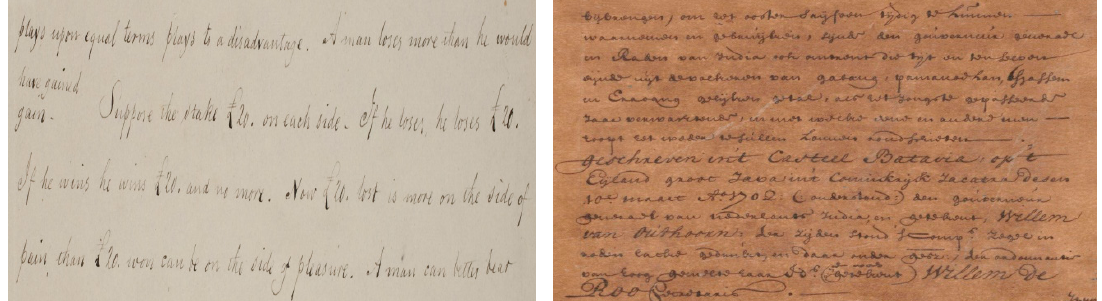
Figure 9. Example showing thin or weak text from old document.